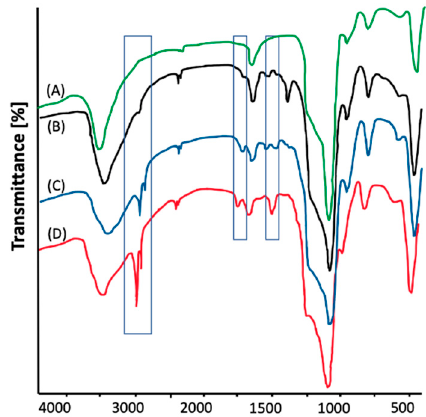
Figure 3. FTIR spectra of ( A ) unmodified MSNs, ( B ) MSNs-Br, ( C ) PTBAEMA-MSNs, and ( D ) PTBAEMA-b-PEGMEMA-MSNs.